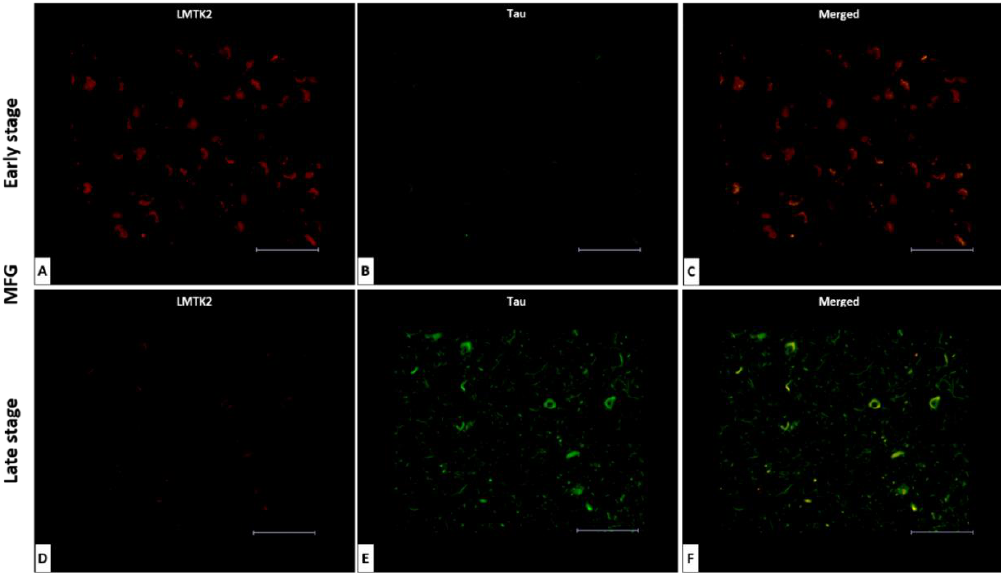
Figure 3. Lemur tyrosine kinase 2 (LMTK2) and phospho-tau fluorescent double-labelling immunohistochemistry in the middle frontal gyrus (MFG) in early ( A – C ) and late ( D – F ) neuropathological Braak tau stages. LMTK2 immunolabelling (red) dominates the early neuropathological stage ( A,C ), which is spared by neurofibrillary tangles (NFT), while there is an obvious phospho-tau burden ( E,F ) with decreased LMTK2 positivity ( D ) in the late neuropathological stage. LMTK2 and phospho-tau were visualized by Alexa Fluor 594 and Alexa Fluor 488 fluorescent dyes, respectively. Scale bar: 50 µm.